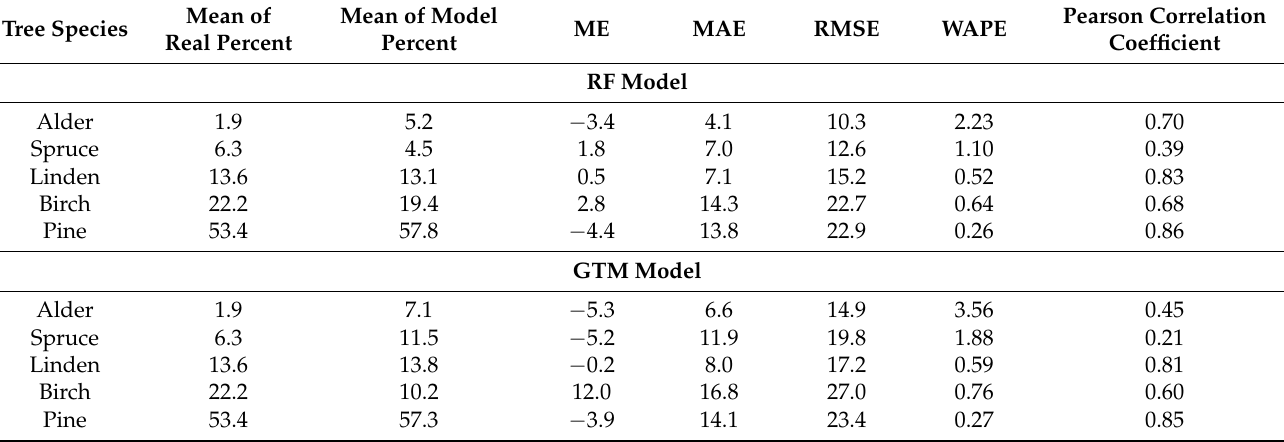
Table 6. Comparison of real and model percent abundance values of tree species in